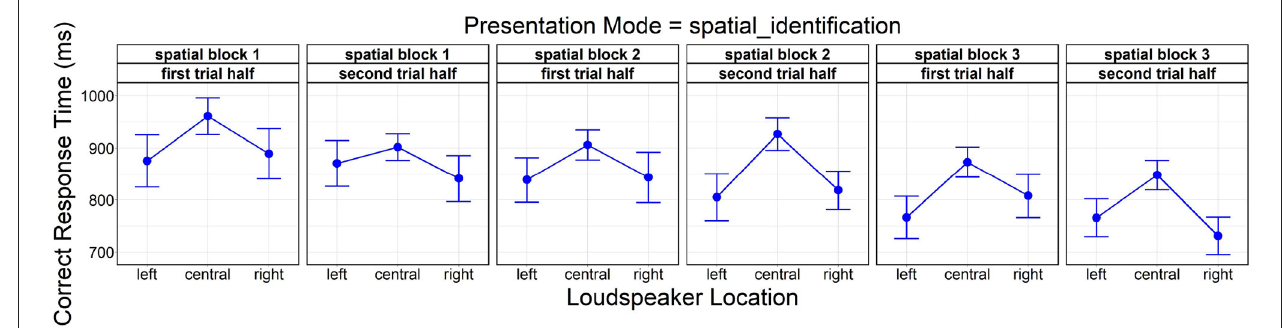
FIGURE 6 | Effects of loudspeaker location , spatial block (spatial block 1, spatial block 2, spatial block 3), and lateral trial half (first trial half, second trial half) on correct response time. Error bars represent 95% confidence intervals. Another version of this figure originally appeared in Uhrig (2022), copyright 2021, with permission from Springer.